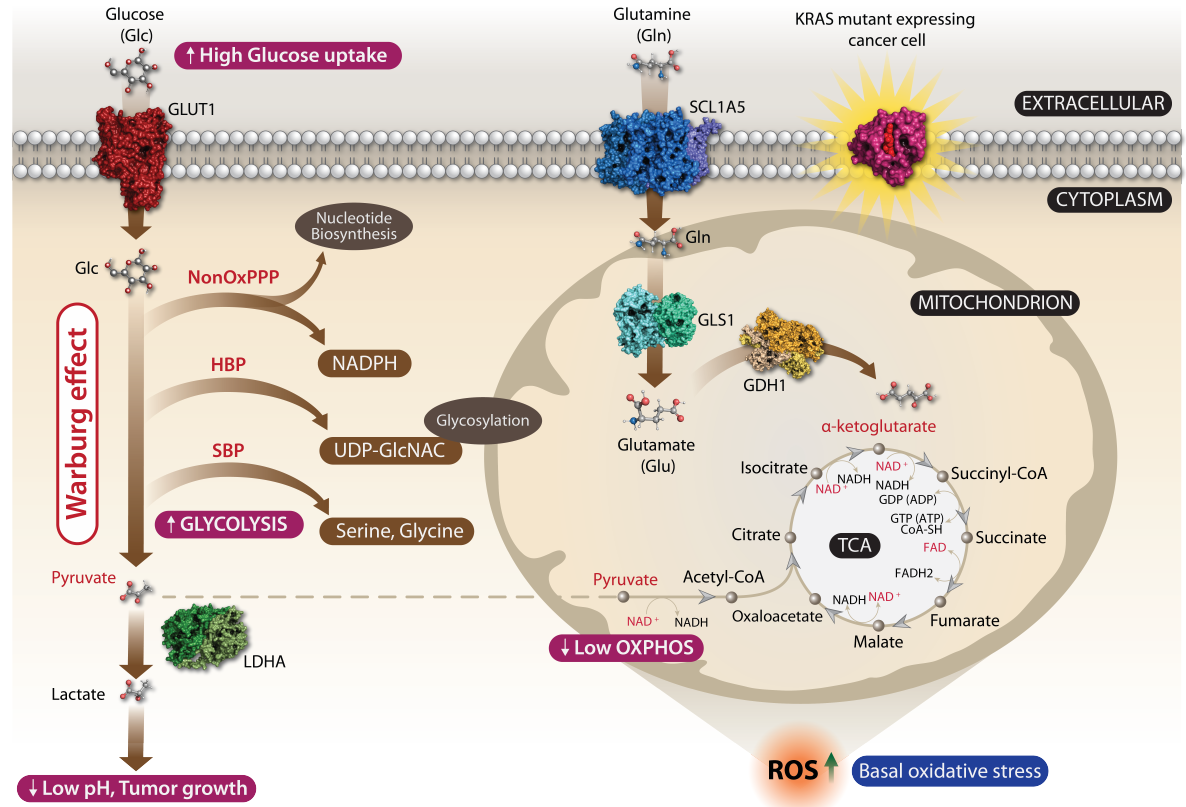
Figure 5. The Warburg effect in RAS-expressing cancer cells. RAS-expressing cells are exposed in the tumor microenvironment to hypoxia, acidosis, and stromal cell formation that significantly affect the glycolysis as well as important signaling such as PI3K and HIF1 (not displayed). All these lead to an additional impairment in the efficiency of the TCA cycle, where the OXPHOS is decreased. The major alteration comes from the choice of cancer cells to preferentially metabolize anaerobically glucose, even under normoxia, which is referred to as the Warburg effect. RAS-expressing cells show high glucose uptake by GLUT1, a major increase of the glycolysis and the massive production of lactate catalyzed by LDHA, from which only a very small amount enters the mitochondria. The majority of lactate is transported outside of the cell, further promoting low pH and tumor growth. In parallel with the decreased overall flux of pyruvate through the TCA cycle, there is an increase of the utilization of glutamine, in particular its carbon backbone and amino moiety either by entering the TCA cycle as α -ketoglutarate or transamination to sustain biosynthetic metabolic pathways such as amino acid, nucleotide, and glutathione synthesis. Glutamine is transported to the cell through the SCL1A5 transporter, entering the mitochondria where GLS1 hydrolysis converts it to glutamate and ammonia. Glutamate is then converted by oxidative deamination to α -ketoglutarate and ammonia catalyzed by GDH1 and enters the TCA cycle. Abbreviations: PI3K,